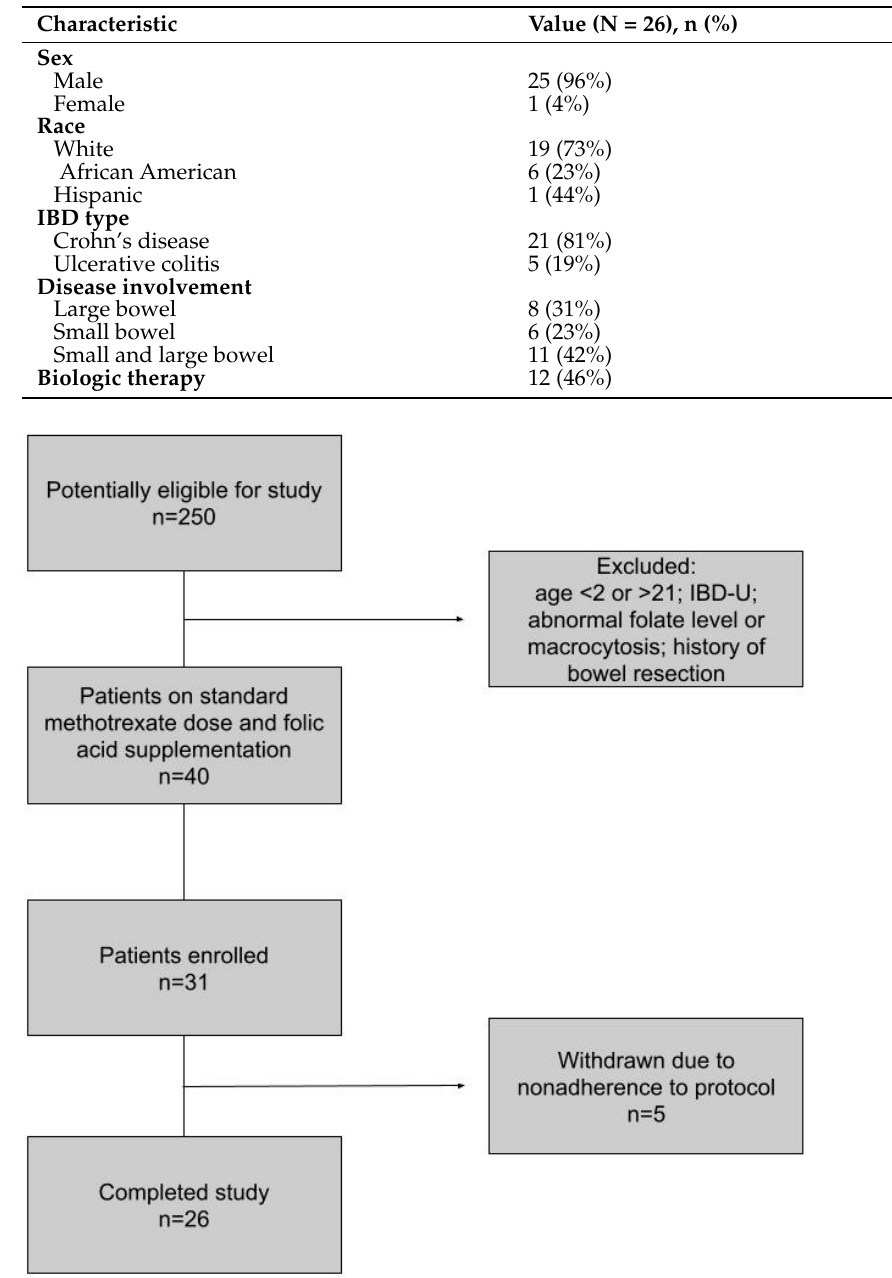
Table 1. Demographics and selected clinical features of the study population.